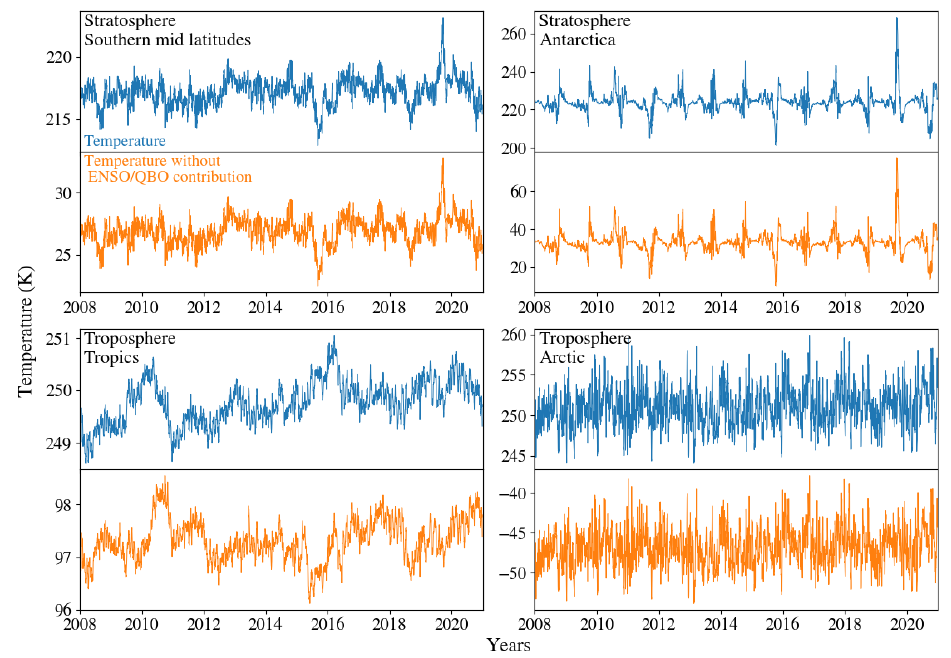
Figure 11. Time series of temperatures in the four rectangles of Fig. 10 (blue) and time series without ENSO and QBO contributions (orange). The exact locations of the four regions are 45–60 ◦ S and 100–70hPa for southern-stratosphere mid-latitudes, 80–90 ◦ S and 10–7hPa for the Antarctic stratosphere, 20 ◦ S–20 ◦ N and 550–200hPa for the tropical troposphere, and 75–90 ◦ N and 750–550hPa for the Arctic